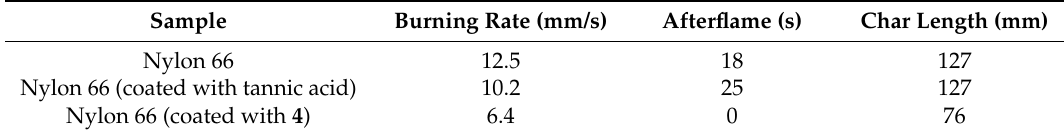
Table 3. Vertical flame test data.